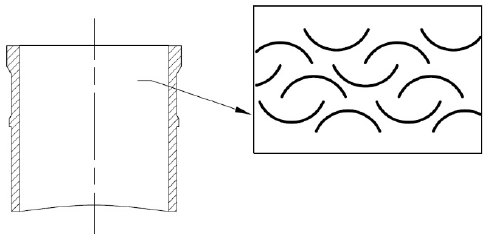
Figure 19. Laser-etched cylinder liner, after [120].